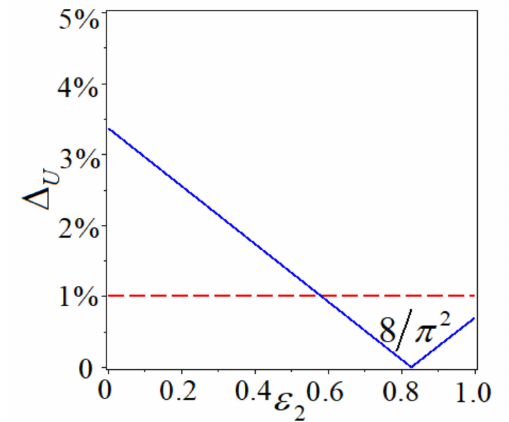
Figure 6. Relative errors curve ∆ U − ε 2 of Equation (2.3c) when α = 2.0, h 2 = − 0.465.